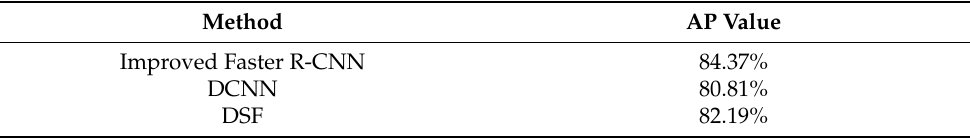
Table 7. Quantitative comparison between different algorithms.